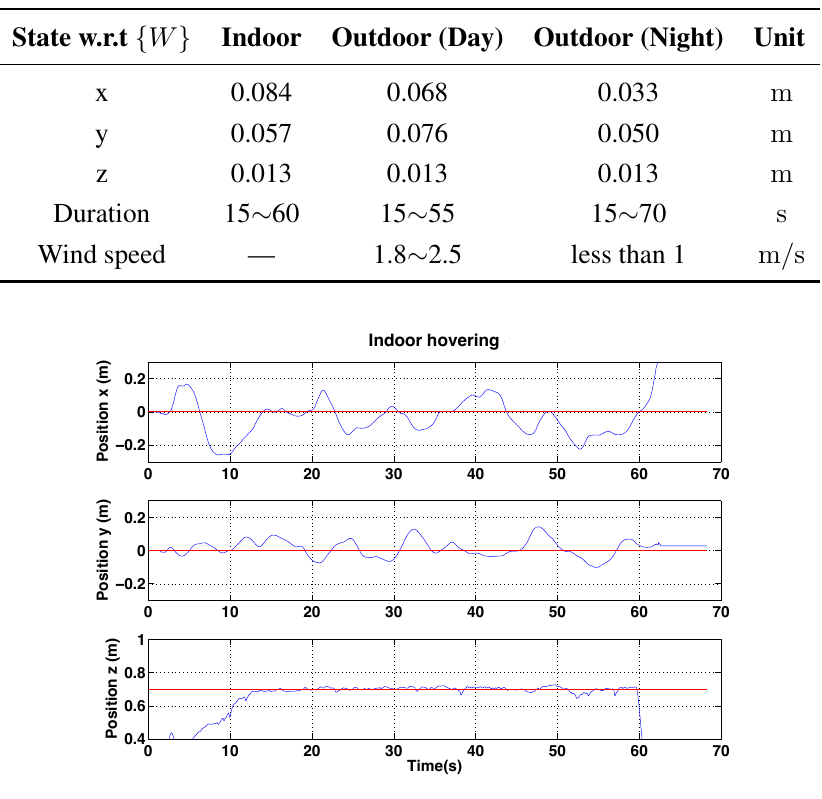
Figure 30. Experimental results for IBVS-based hovering: control performance for indoor IBVS-based hovering. Goal positions shown in red.